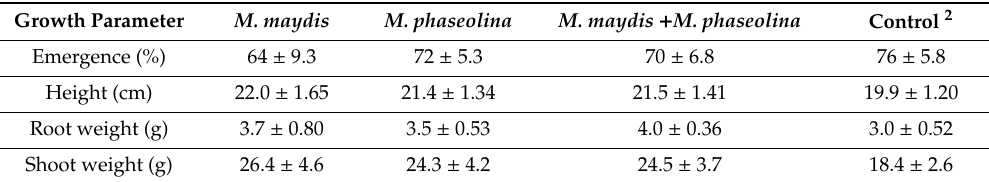
Table 4. Maize average growth indices at 34 DAS 1 as a result of infection with M. maydis and M. phaseolina (the 2018